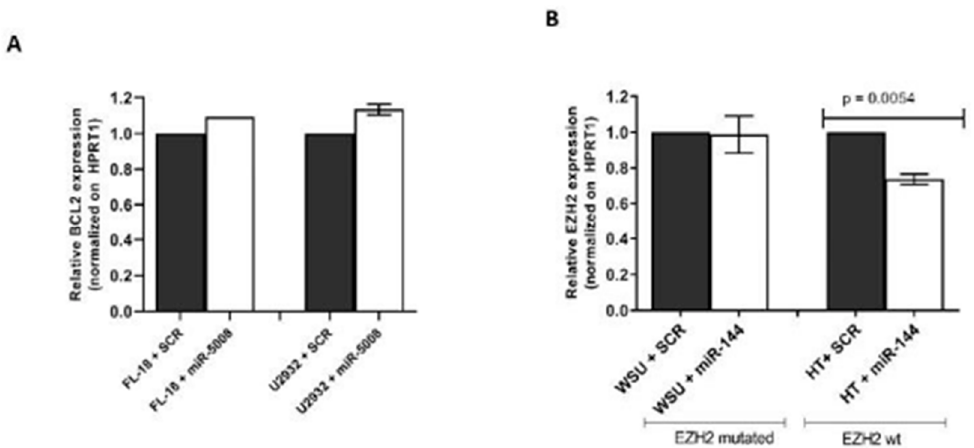
Figure 4. Effect of adding selected miRNAs to endogenous expression levels of target genes. ( A ) BCL2 expression in lymphoma cells transfected with miR-5008 . BCL2 expression levels were measured using RT-qPCR in FL-18 and U2932 lymphoma cell lines. ( B ) EZH2 expression in lymphoma transfected with miR-144. SCR refers to a scramble miRNA sequence used as a negative control.